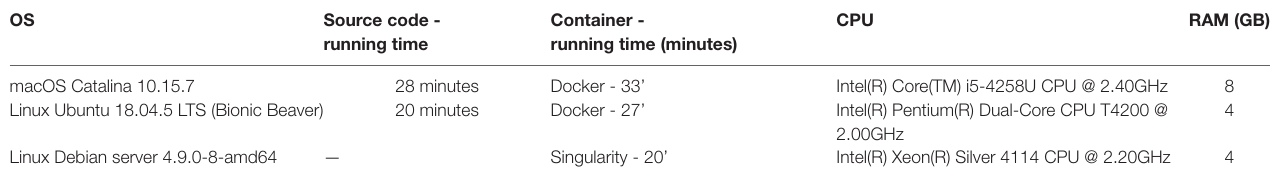
TABLE 2 | The platforms where the CLI workflow was